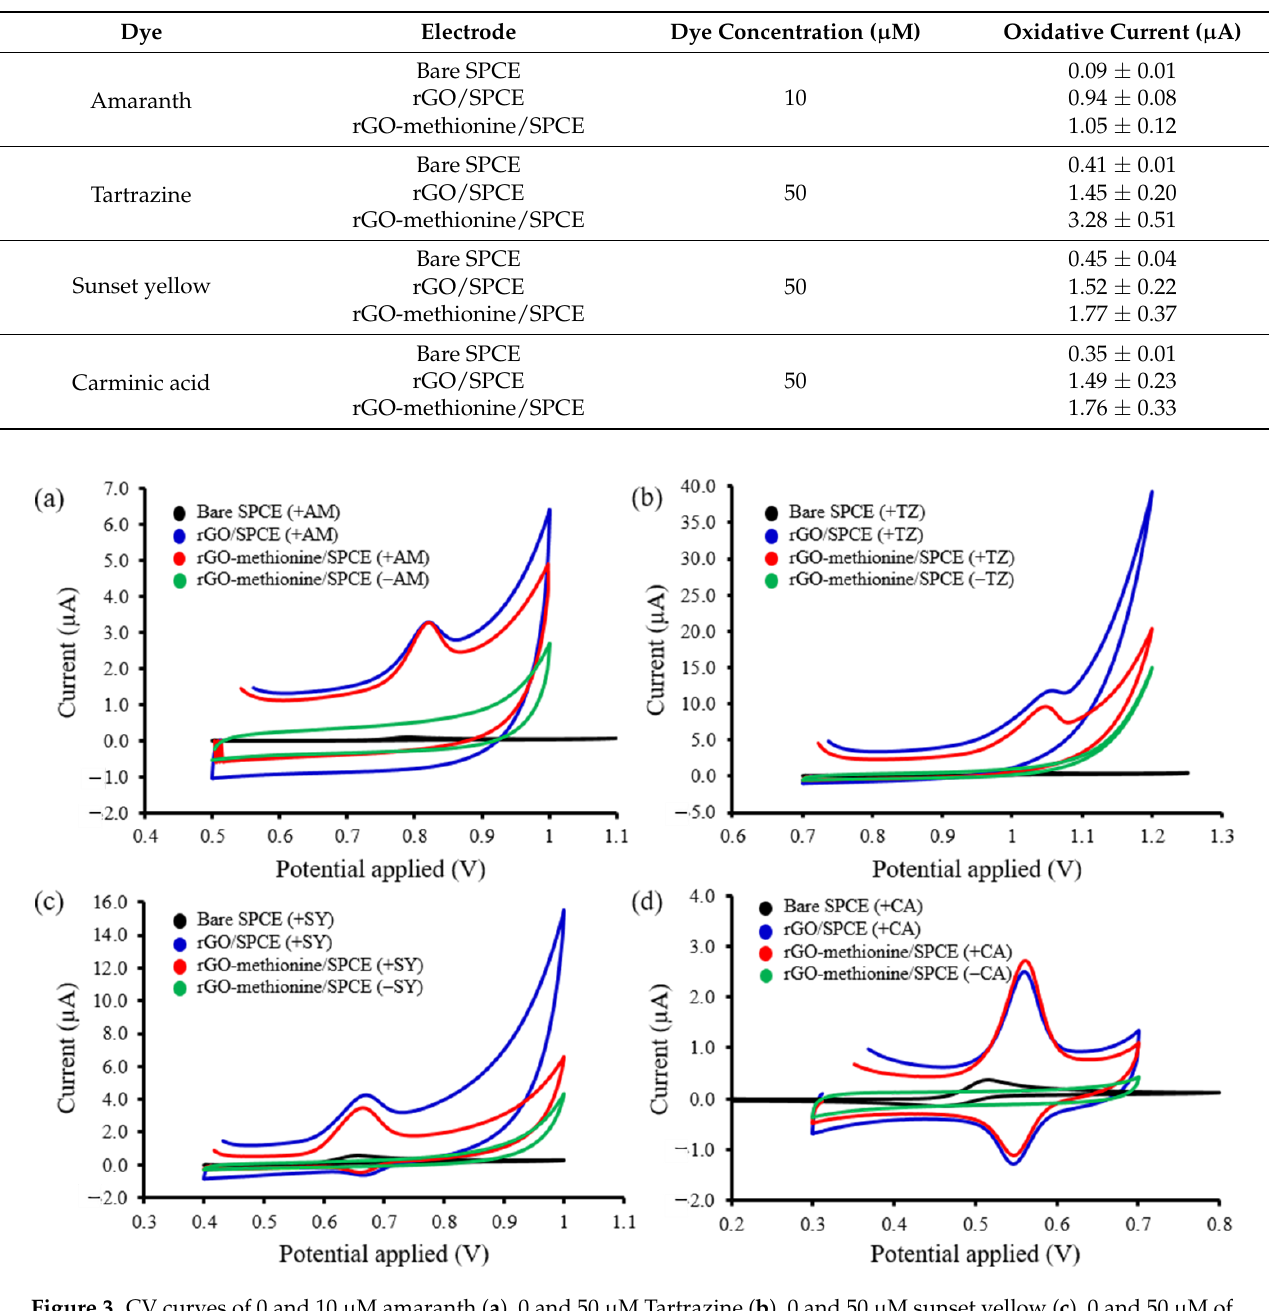
Table 1. Electrochemical response of amaranth, tartrazine, sunset yellow, and carminic acid on bare SPCE, rGO/SPCE, and rGO-methionine/SPCE.